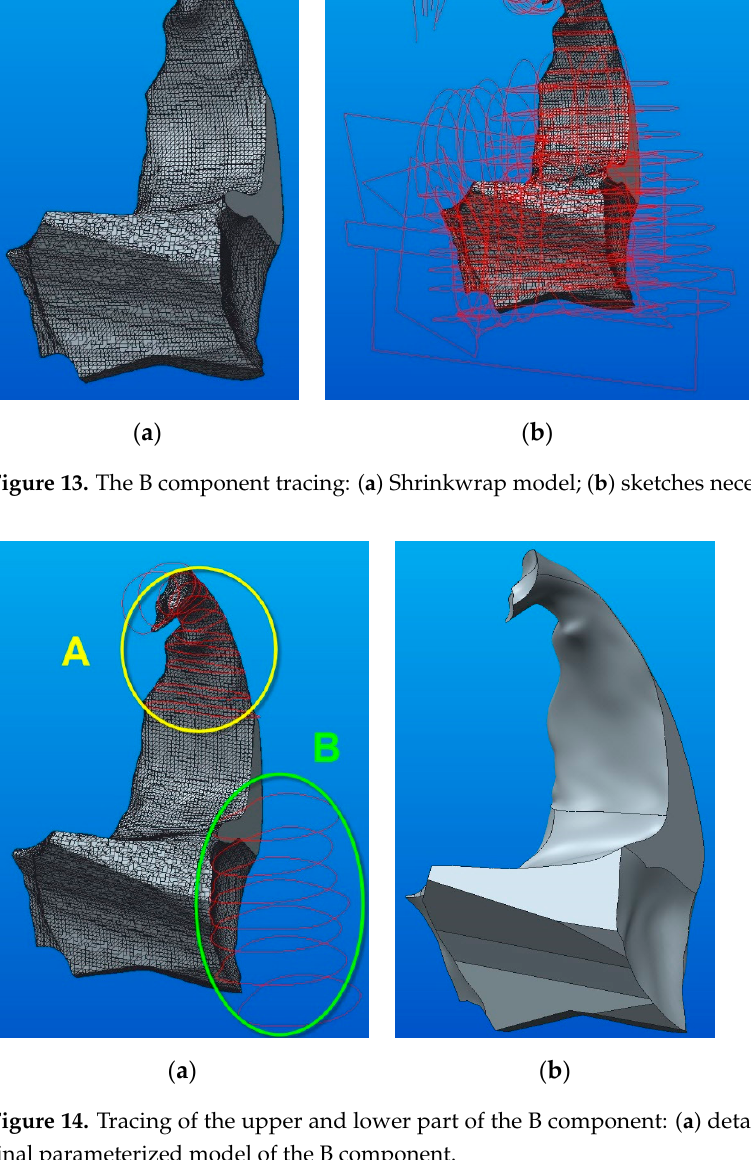
Figure 14. Tracing of the upper and lower part of the B component: ( a ) details of sketches; ( b ) the final parameterized model of the B component.